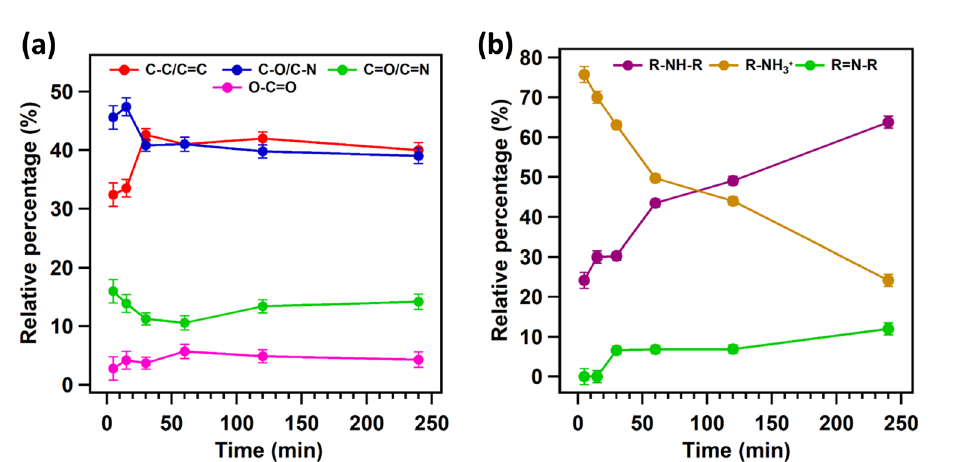
Fig. 7 | Evolution of carbon and nitrogen species during polymerization. Time-dependent evolution of a C1 s and b N1 s components for HNT-PDA during dopamine polymerization. The error bars represent the standard deviation of the experiments.